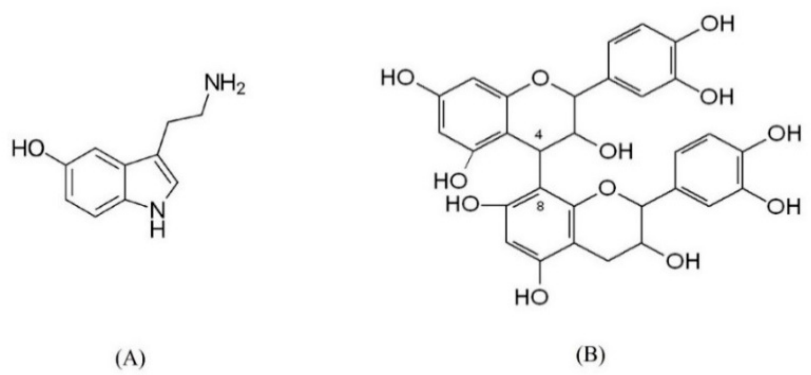
Figure 1. Chemical structure of serotonin ( A ) and B-type procyanidin ( B ), represented by 4–8 epicatechin dimer.